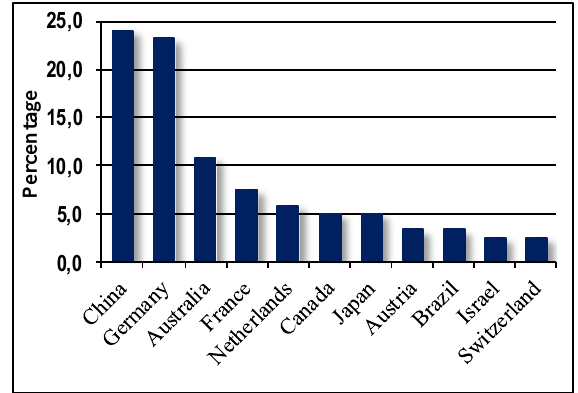
Figure 10. Countries that made major contribution in